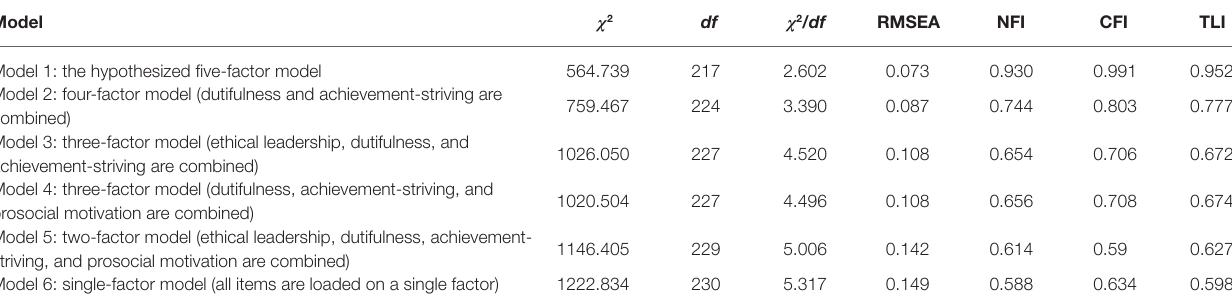
TABLE 1 | Model fit results for confirmatory factor analyses.